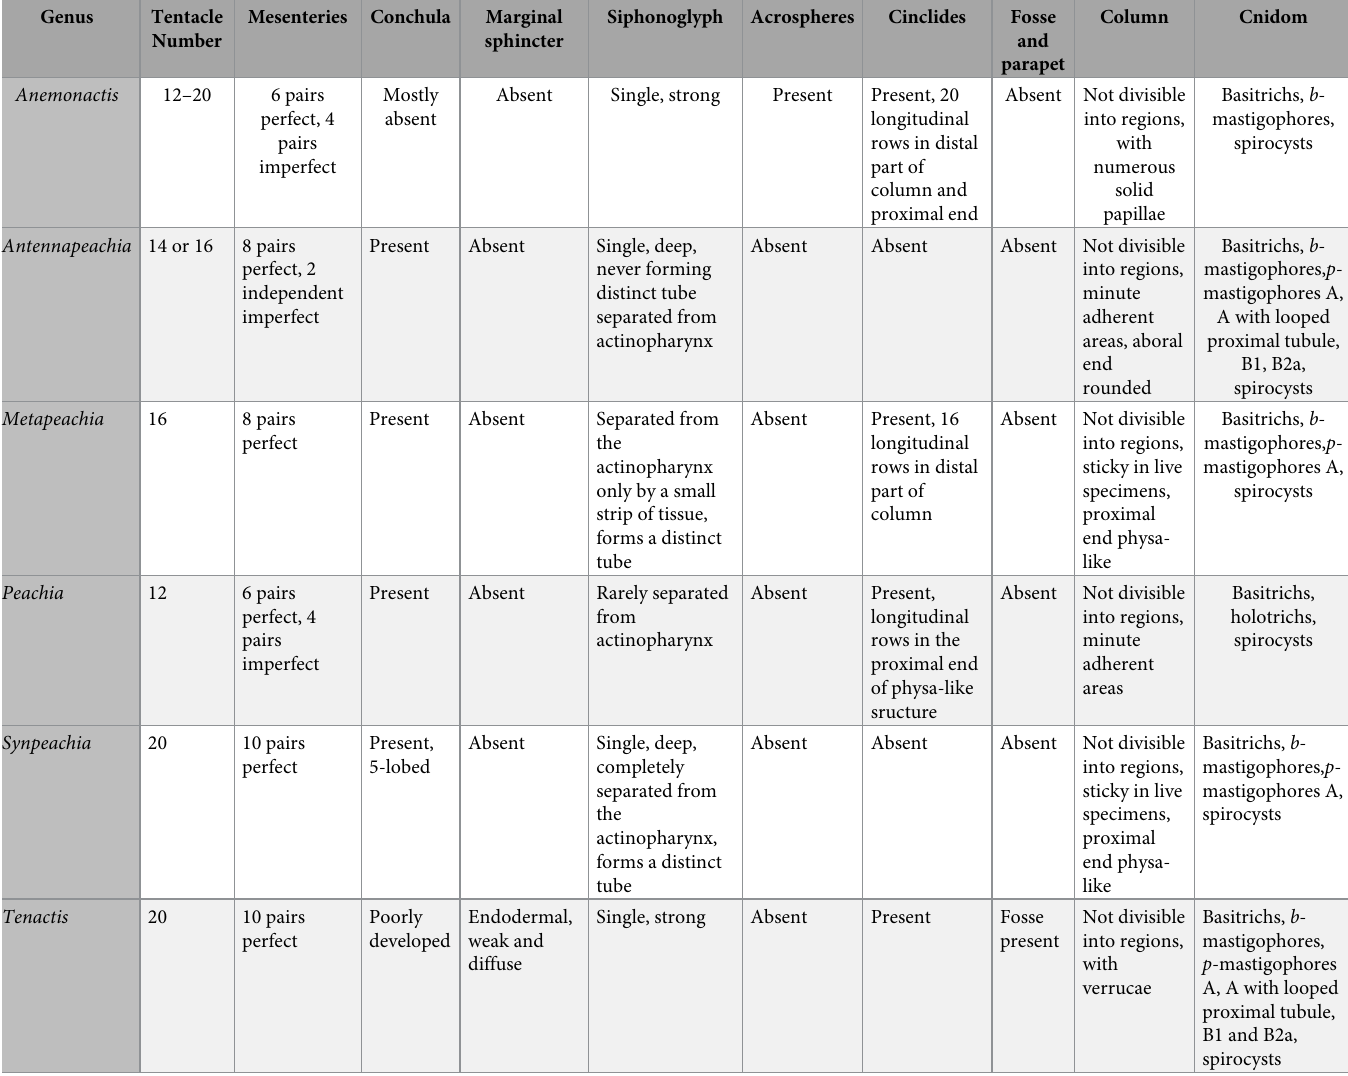
Table 3. Morphological differences in species with conchula previously placed in Haloclavidae (Verrill 1899).